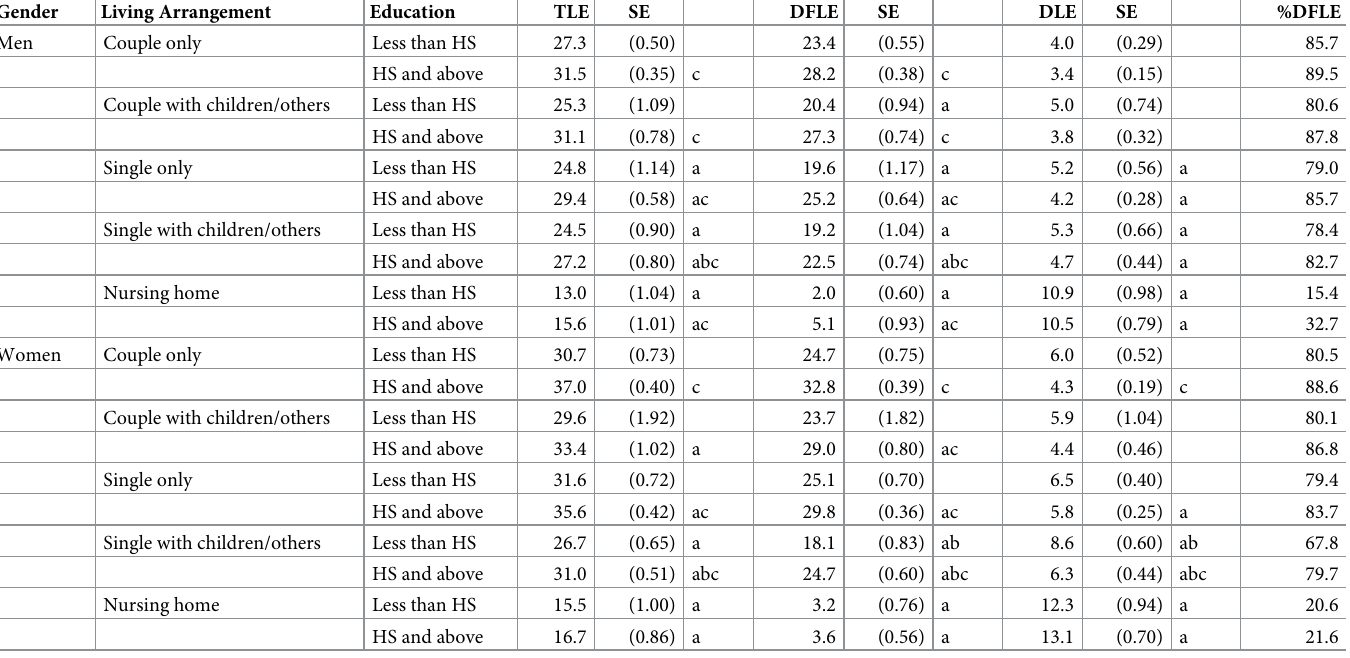
Table 10. Total, disability-free, and disabled life expectancy by gender, living arrangement, and education for non-Hispanic whites at age 50: Population-based